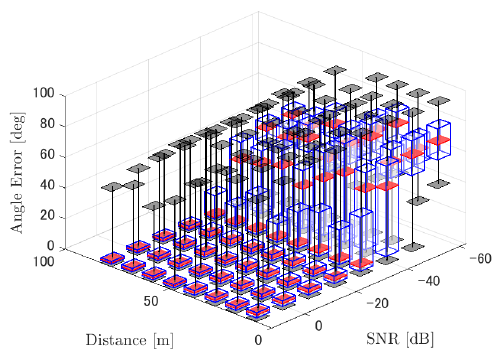
Figure 20. Box plot of the direction estimation error for the lower right microphone array in Figure 2. Considered scenario is tracking a circular motion sound source emitting a male voice.